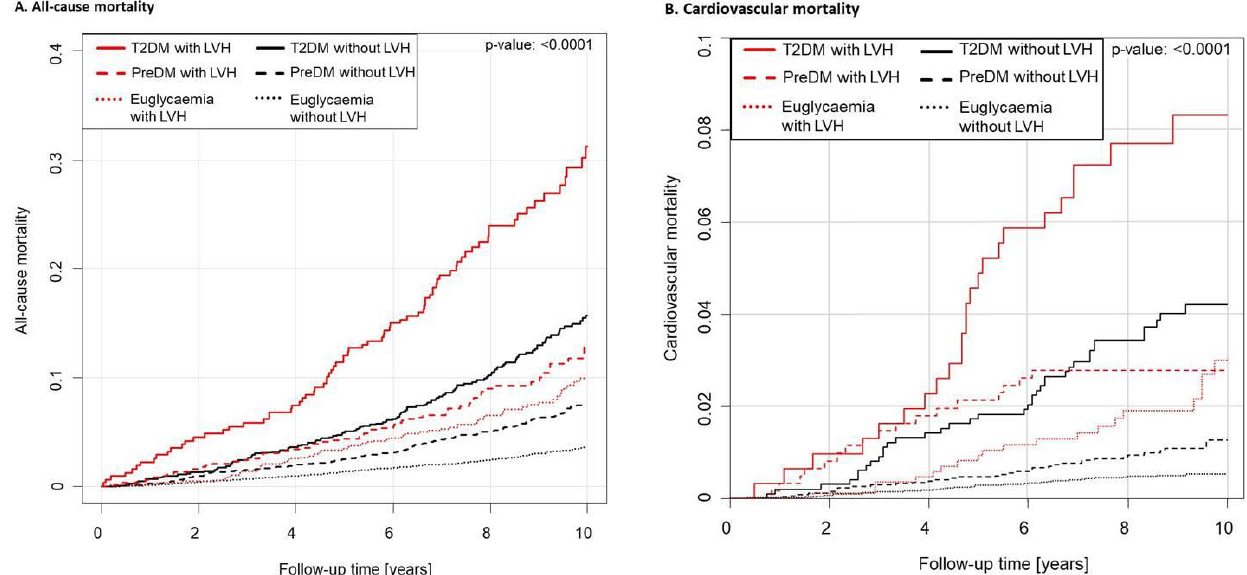
Figure 2. Mortality by diabetic state and presence of LVH. Compared all-cause mortality ( A ) and cardiovascular mortality ( B ) regarding diabetic state in individuals with and without left ventricular hypertrophy (LVH). Mortality in individuals with prediabetes and LVH was as high as in diabetes without LVH. A total of 808 deaths were registered within a median observational follow-up time of 9.04 years (IQR 7.7–10.0 years). In 12,958 individuals without LVH, 596 deaths including 117 fatal cardiovascular events were recorded, and of 1791 individuals with LVH 205 deaths were notified (60 events of cardiovascular reasons). The p -value of the log-rank test is given in the